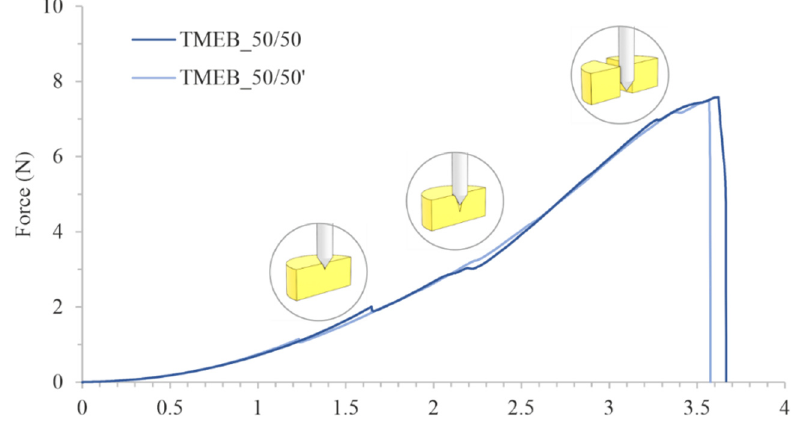
Figure 9. Comparison of the mechanical properties of drug-loaded tablets.